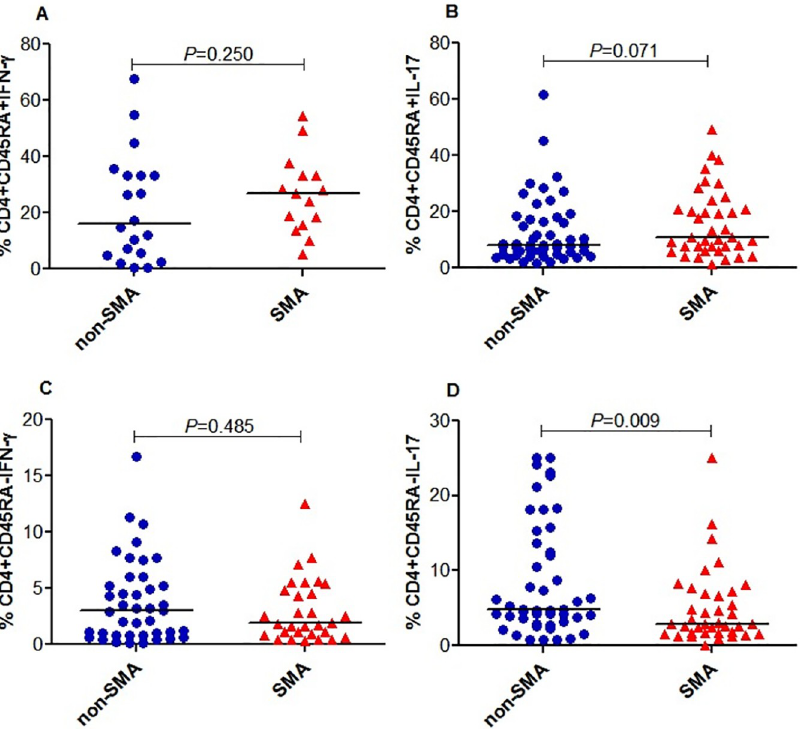
Fig 3. Memory-like CD4+ T-cells expressingIFN- γ and IL-17 in acute malaria. Data are presentedas proportions (%). The proportions were determinedby flow cytometry immediately after staining. The proportions of different lymphocyte populationswere determined using Flowjo Software (TreeStar, Ashland, OR, USA). The line in the middlerepresentsthe median value. Betweengroups comparisons were performed by Mann-Whitney U test. The proportionof CD4+ T-cells was comparable betweenthe groups(data not shown). (A) The proportionof na ï ve-likeCD4+ T-cells expressingIFN- γ was comparable between the groups. (B) The proportionof na ï ve-likeCD4+ T-cells expressingIL-17 was comparablebetweenthe groups. (C) The proportionof memory-like CD4+ T-cells expressingIFN- γ was comparable betweenthe groups. (D) The proportionof memory-like CD4+ T-cells expressingIL-17 was decreased in SMA relativeto non-SMA group.